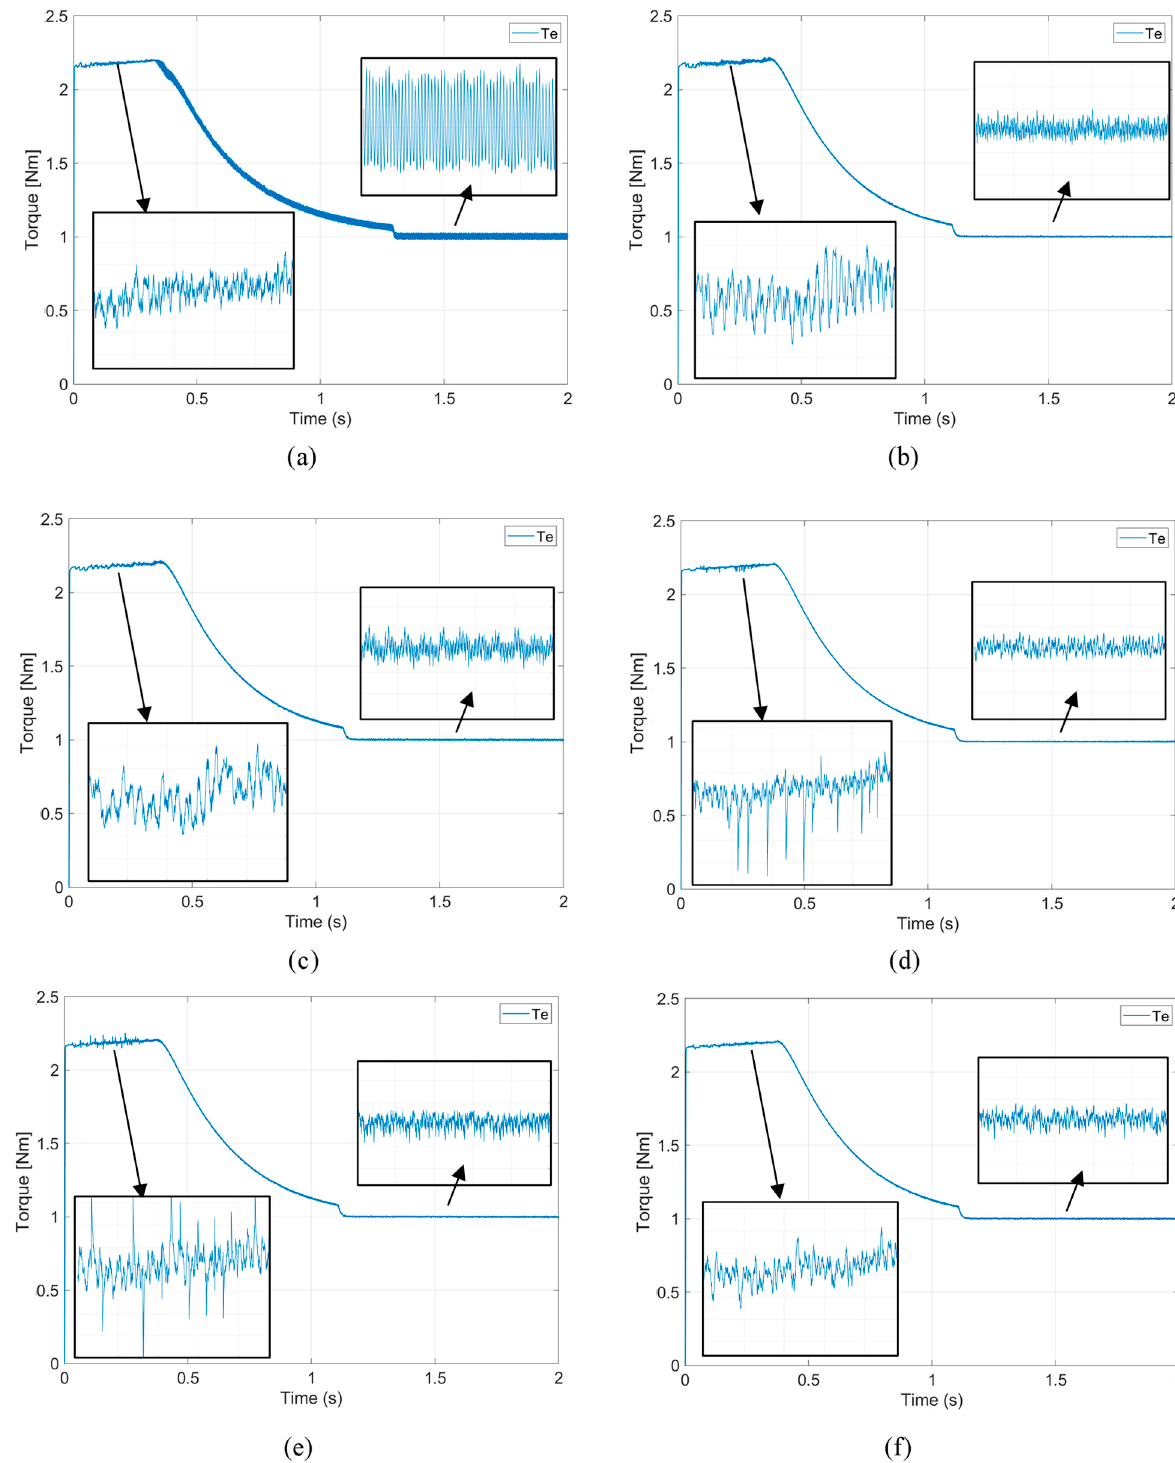
Figure 14. Simulation results of motor torque at 1500 rpm of command and 1.0 Nm of load torque: ( a ) SPWM; ( b ) THPWM; ( c ) SVPWM; ( d ) 60° DPWM; ( e ) 30° DPWM; ( f ) 120° (off) DPWM.